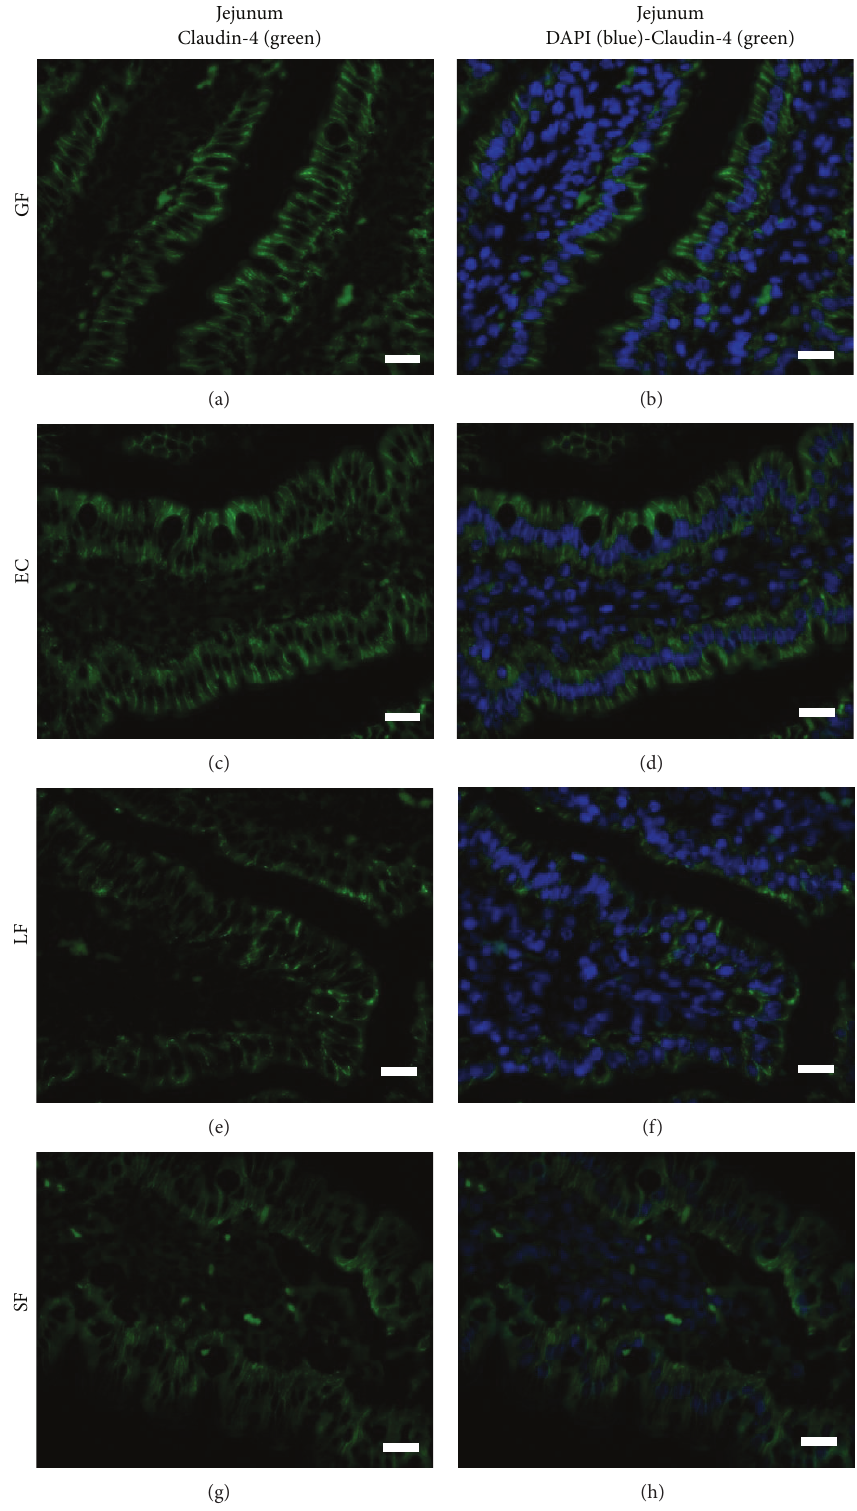
Figure 5: Claudin-4 surface localization in the piglet jejunum is not influenced by colonization by commensal microbiota.In the jejunum of 14-day-old germ-free piglets ((a), (b)), piglets colonized with EC ((c), (d)), LF ((e), (f)), or conventional microbiota (SF; (g), (h)) , Claudin-4 is localized to the surface between adjacent enterocytes. These images are representatives of IHC performed on tissue from 4 animals per time point. Primary antibody: rabbit anti-Claudin-4. Secondary antibody: FITC-labeled goat anti-rabbit (green). Nuclear stain: DAPI (blue). Scale bar represents 40 𝜇